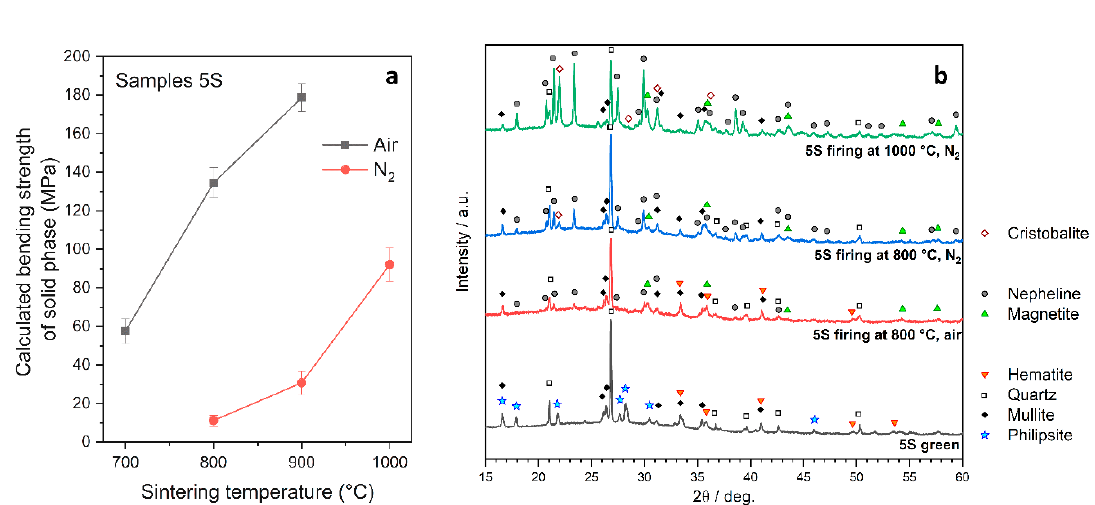
Figure 2. ( a ) Comparison of calculated bending strength of 5S samples fired in the air [15] and in N 2 ; ( b ) mineralogical analysis of selected 5S samples according to thermal treatment.